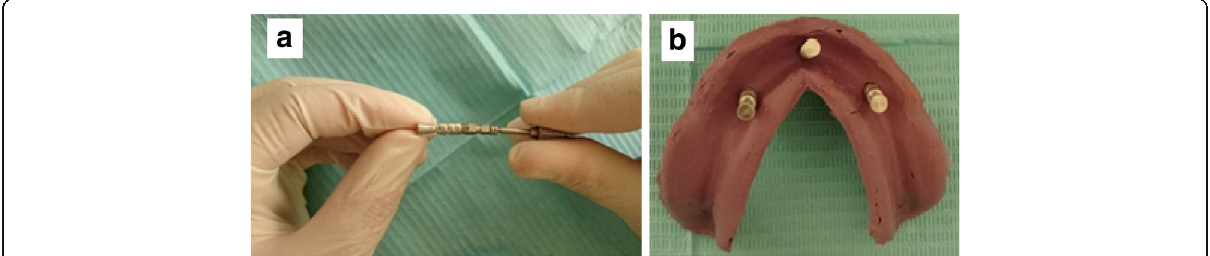
Fig. 1 a Attaching the analog to the coping using the screw driver. b Impression after insertion of the coping-analog till hearing the audible